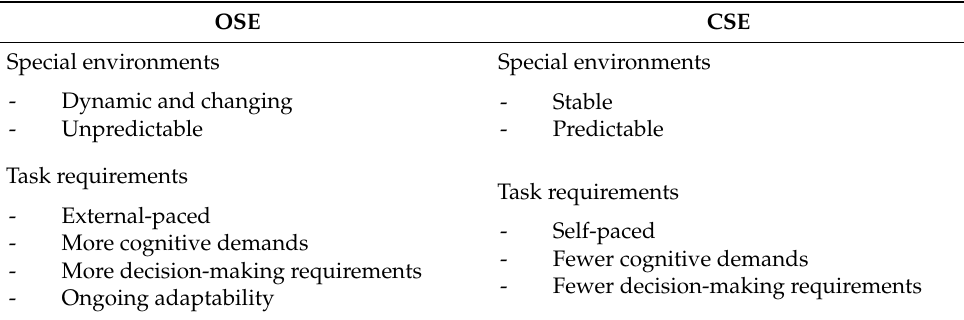
Table 3. Differences in the characteristics of OSE and